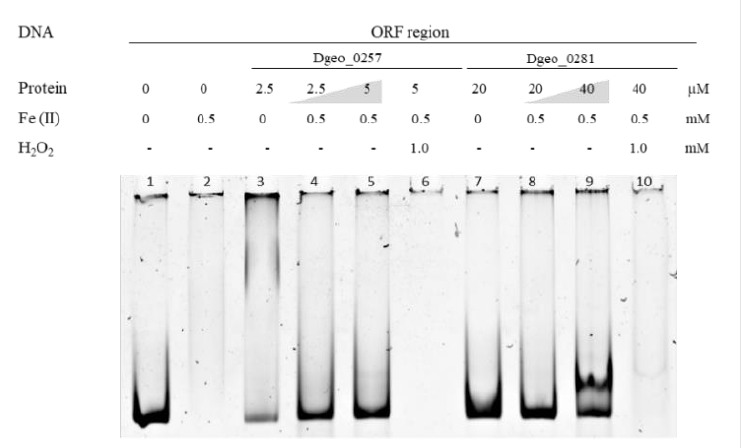
Figure 3. DNA–Dps complex formation and DNA protection analysis from iron treatment and Fenton reactions. Lane 1, free DNA; lane 2, only 0.5 mM Fe 2+ ; lanes 3 and 7, both proteins added with different amounts; lanes 4, 5, 8, and 9, increased Dgeo_0257 and DgDps1 proteins with ferrous ions at 0.5 mM; lanes 6 and 10, Fenton reaction samples with 1.0 mM H 2 O 2 .